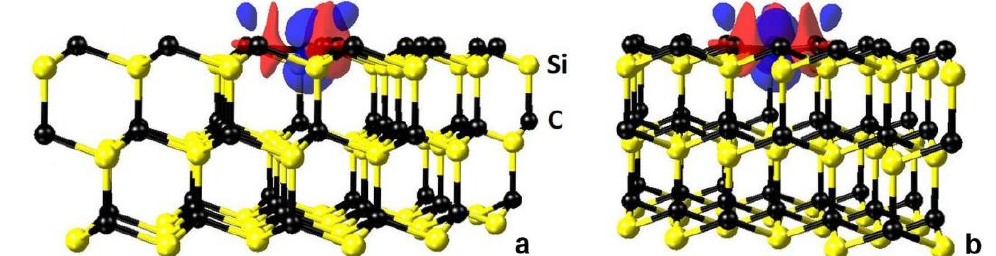
Figure 11. The difference in the density of electrons with spin up and spin down in the model system with a C 4 V center. The border of the blue region corresponds to a difference of 0.05 Å −1 ; the border of the red region corresponds to a difference of −0.01 Å −1 . ( a ) and ( b )—views from different sides.